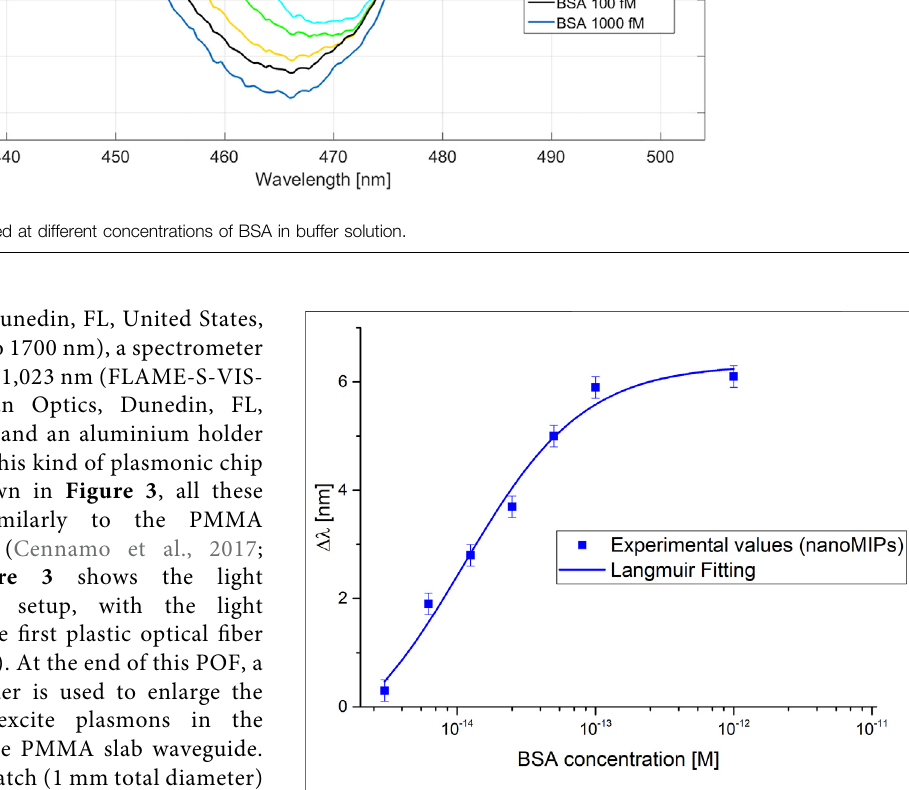
FIGURE 7 | Dose-response curves of the BSA detection in buffer solution exploiting nanoMIPs combined with a not-optimized nanoplasmonic